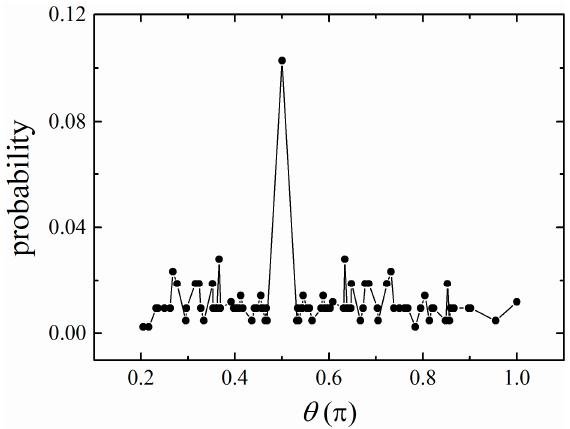
Figure 8. The priori probability of the angle between two successive bond vectors in the bond fluctuation model (BFM). The angle is measured in units of π .